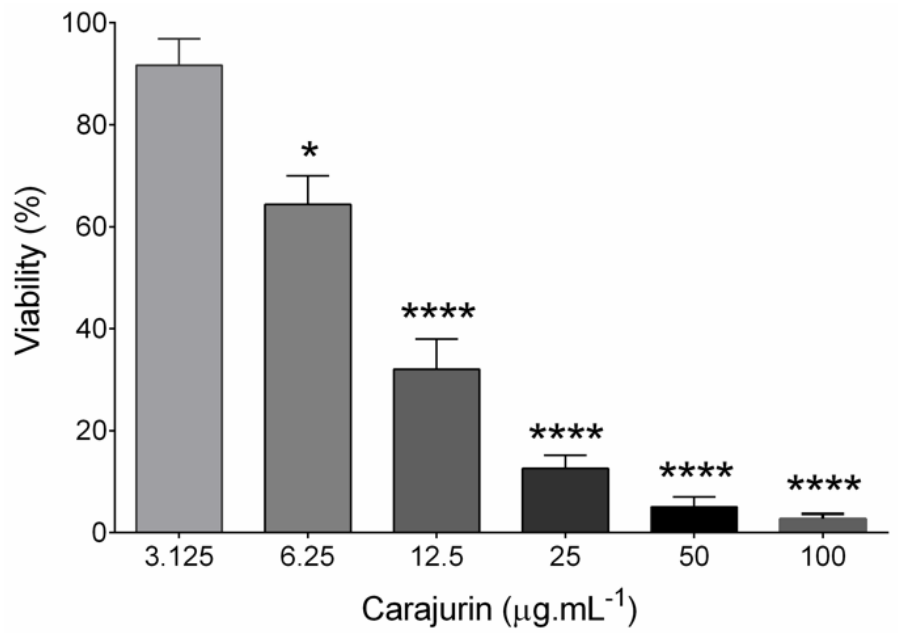
Figure 2. Effects of carajurin on growth of Leishmania amazonensis promastigote forms. Parasites in log-phase (2 × 10 6 mL − 1 ) were incubated in different concentrations of carajurin. Data represent the mean ± standard error of three independent experiments carried out in triplicate. (*) p < 0.05; (****) p < 0.0001, when compared to untreated parasites by Mann-Whitney test. Table 2. Antileishmanial activity, cytotoxicity, and selectivity index of carajurin for 24 h of treatment. Data represent mean ± SD. CC 50 : cytotoxic concentration for 50% of cells; IC 50 : inhibitory concentration for 50% of parasites. SI: selectivity